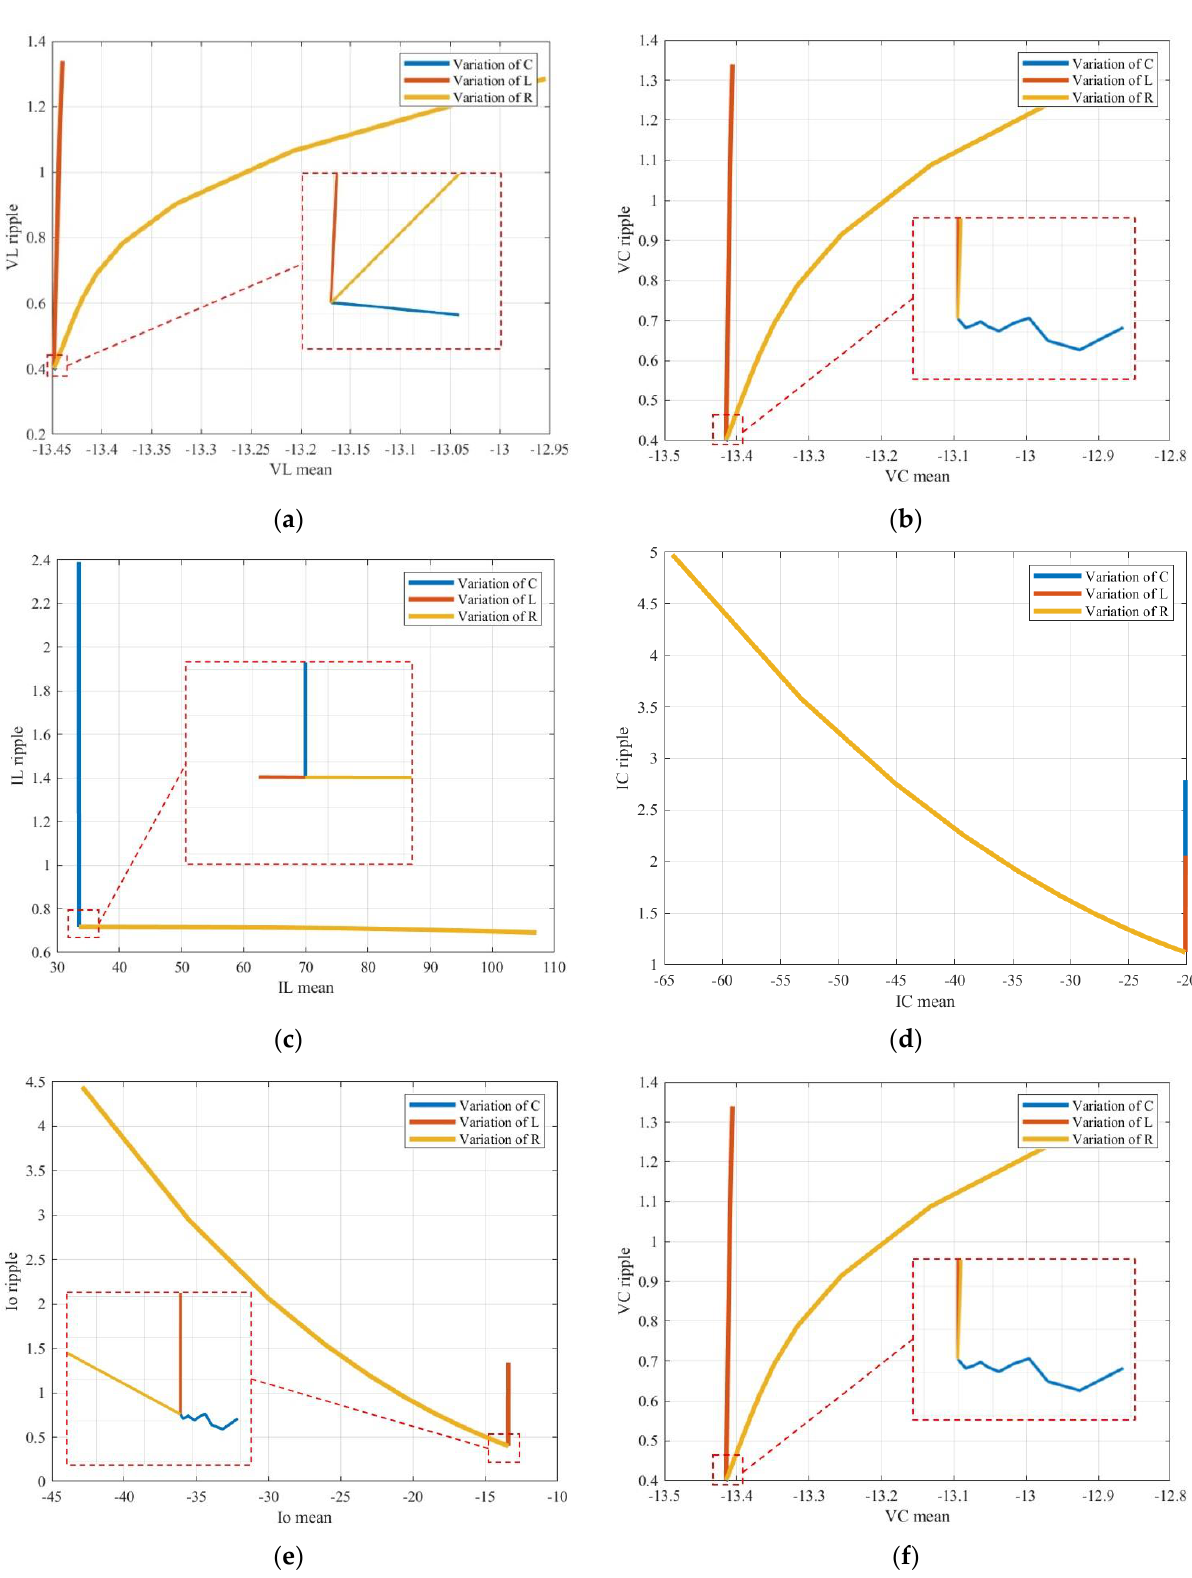
Figure 15. Testability curves for the buck – boost converter in the switch-off period: ( a ) changes in the inductor voltage; ( b ) changes in the capacitor voltage; ( c ) changes in the inductor current; ( d ) changes in the capacitor current; ( e ) changes in the output current; ( f ) changes in the output voltage.